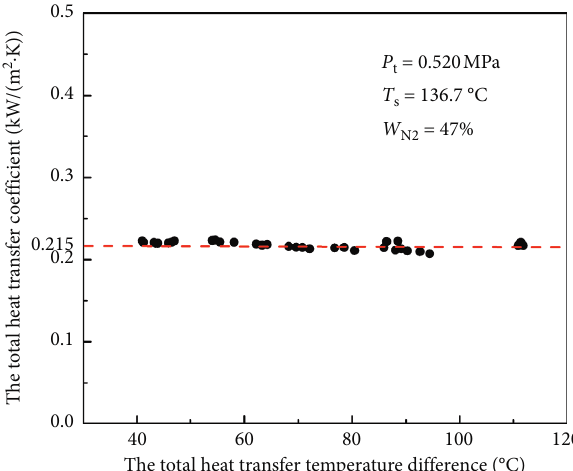
Figure 6: The effect of total heat transfer temperature difference on steam